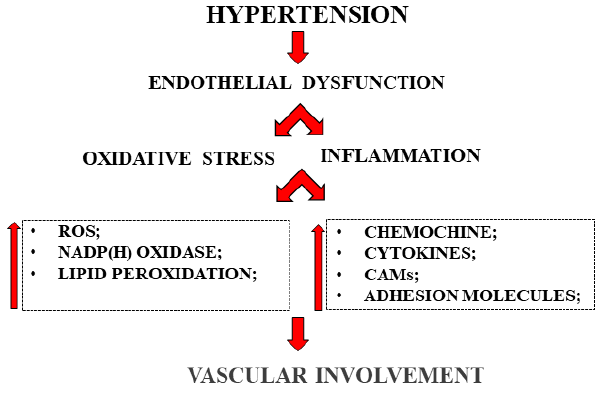
Figure 3. Endothelial involvement in hypertension.